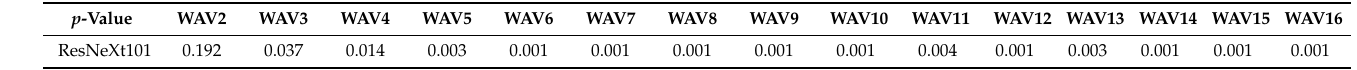
Table 9. p -values of McNemar test between the single CNN model with the highest value of accuracy (ResNeXt101) and WAV from top2 to top16. WAV: weighted average voting.